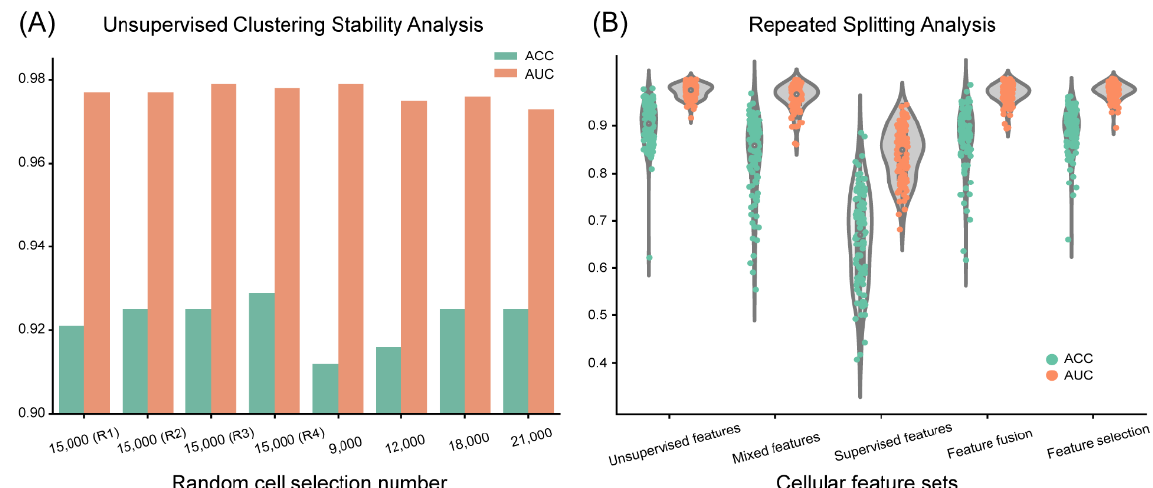
Figure 7. Stability and repeated splitting analysis of the proposed unsupervised clustering cellular feature engineering: ( A ) Eight random cell selections, with four times a random selection of 15,000 cells and one-time respective selection of 9000, 12,000, 18,000, and 21,000 cells, show similar diagnostical performance in general. The accuracy decreases when selecting a smaller number of cells (9000 and 12,000), whereas selecting a larger number of cells (greater or equal to 15,000) presents consistent performance. ( B ) In the 100 times repeated splitting experiment, the extract cellular features via the unsupervised clustering strategy demonstrates superiority over the four compared feature sets on both accuracy and AUC. The feature selection manner exhibits the closest performance with the unsupervised cellular features among all compared methods.